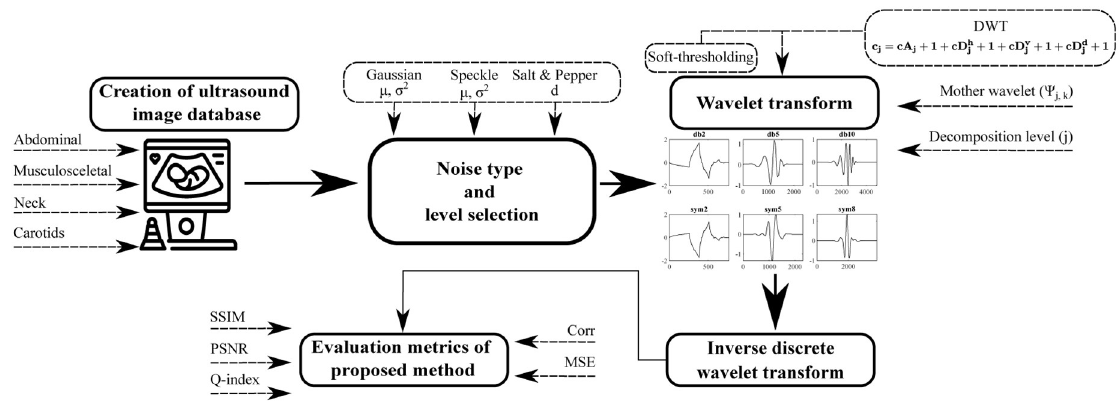
Fig 1. A simplified diagram of an experimental environment for testing and evaluation of dynamical wavelet behavior.